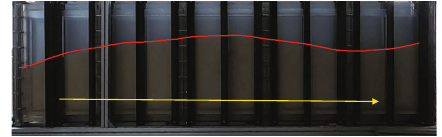
Figure 15: 20/40 mesh ceramsite sand embankment con fi guration with sand-carrying liquid viscosity of 15mPa